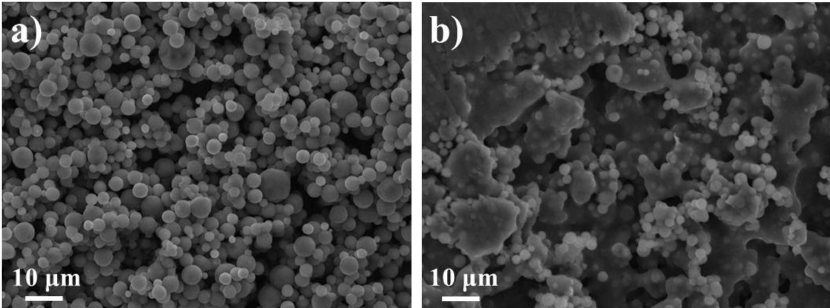
Figure 5. SEM images of as-sprayed powders after 6-h exposure to atmosphere: ( a ) the tin oxalate-dextrin composite is stable; ( b ) the tin oxalate-sucrose composite is hygroscopic. (Adapted from [122] with permission—© 2014 Wiley-VCH Verlag).